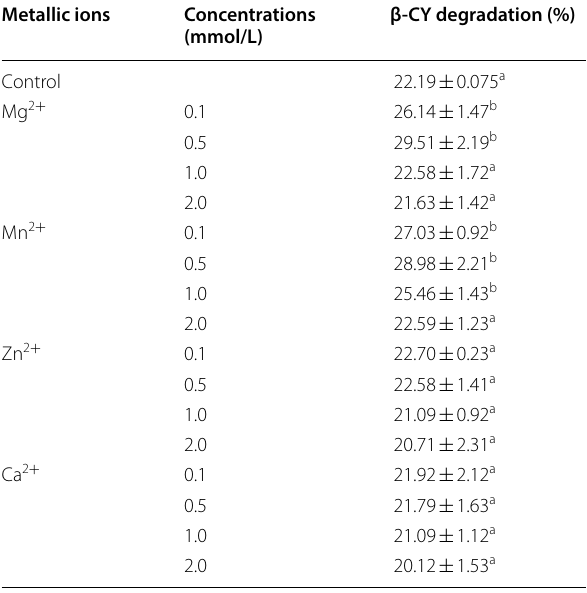
Data are presented as mean standard deviation of three replicates; the ± standard deviations are within 5% of the mean. Different letters indicate significant differences ( p < 0.05)